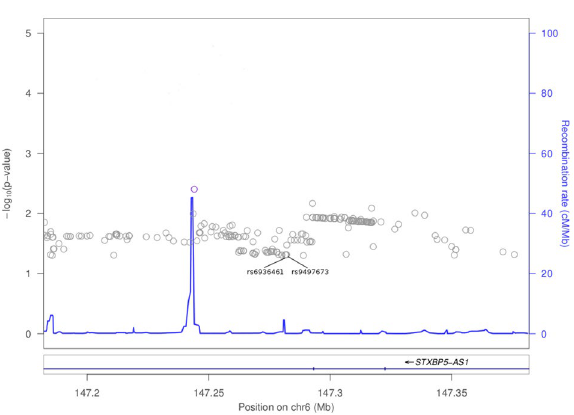
Figure 2. Association plot for 100 kb region flanking rs6936461 on chromosome 6.